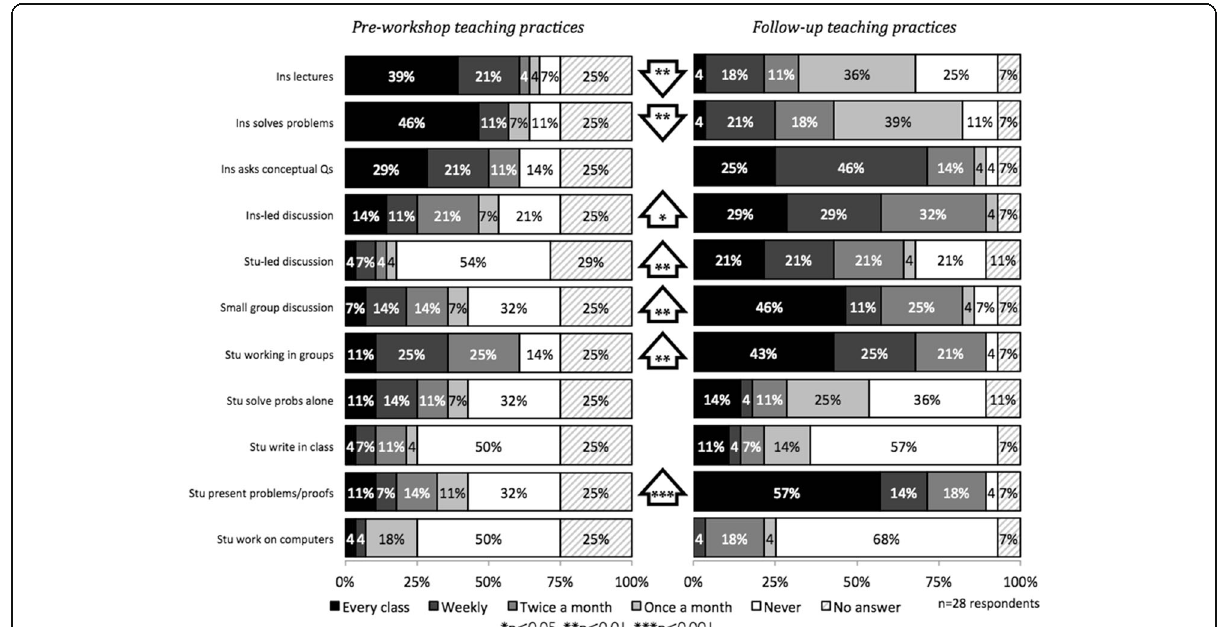
Fig. 3 Changes in frequency of use of teaching practices from pre-workshop to 1-year follow up ( n =28 participants). (Adapted from Hayward, Kogan, and Laursen